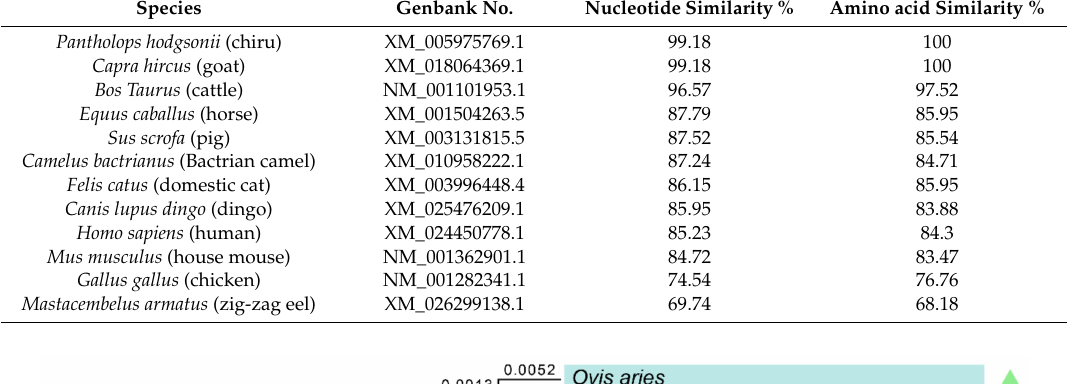
Table 2. Alignment of the similarity of the GLOD4 nucleotide and amino acid sequence of sheep and other species.